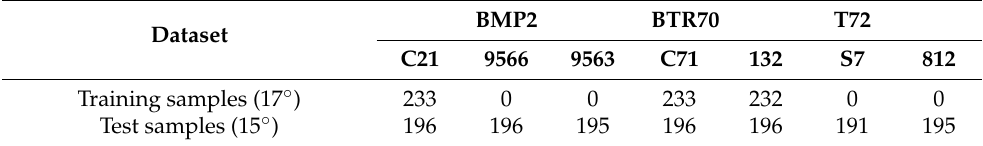
Table 2. Details of Training and Test Samples for the Three-Target